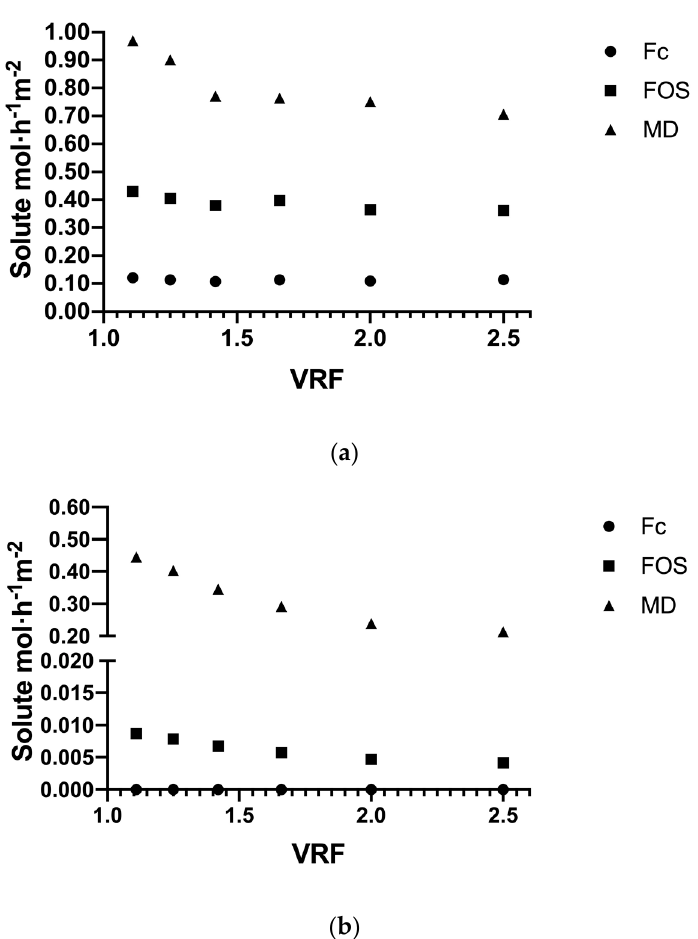
Figure 6. Time evolution as function of volume reduction factor (VRF) of the permeate flux of di ff erent solutes during the tight ultrafiltration process for ceramic membrane ( a ) and polymeric membrane ( b